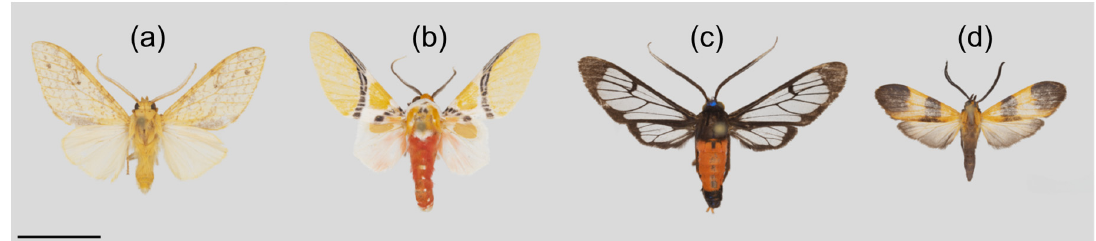
Figure 2. Exemplar species of Arctiinae scored as ( a ) cryptic, ( b ) aposematic, ( c ) Hymenopteran mimic, and ( d ) Lycidae beetle mimic. Species on display are (from left to right): Lophocampa debilis Schaus; Idalus critheis Druce; Cosmosoma hector Staudinger; Correbidia sp. nr. terminalis Walker. Scale bar: 1 cm.